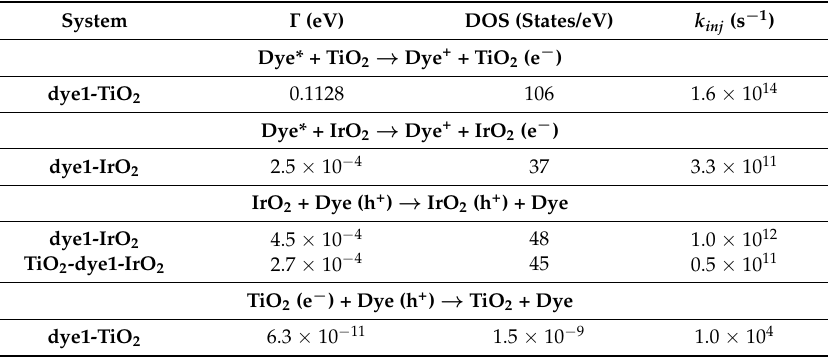
Table 4. Probability distributions, Γ ( ε ) (eV), and DOS (number of states/eV) calculated at the diabatic HOMO and LUMO energies, and associated injection rates, k inj (s − 1